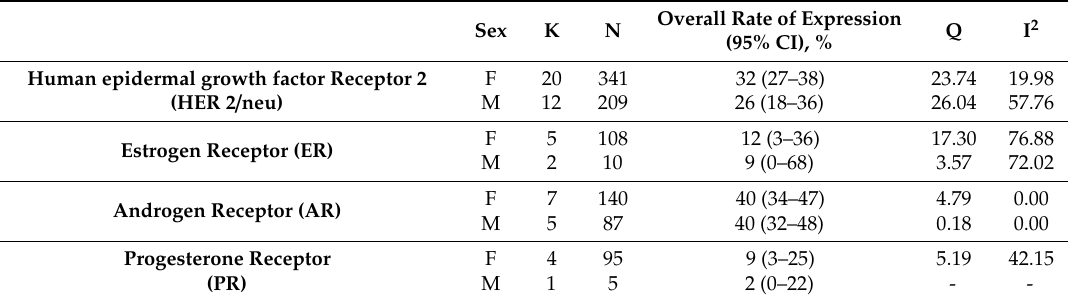
Table 2. Summary of meta-analytic results.